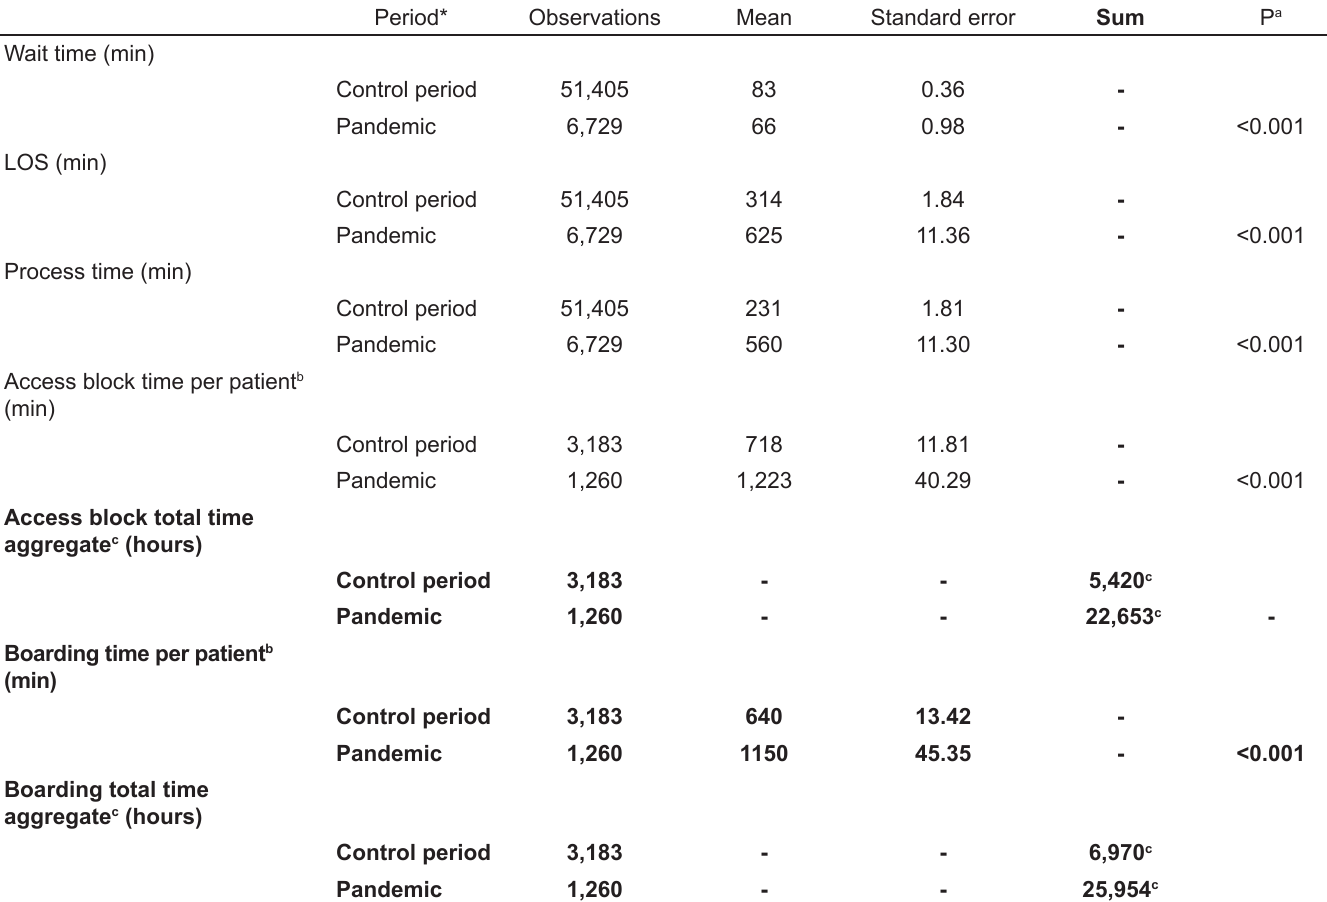
Table 4. Selected time variables accounting for crowding, by